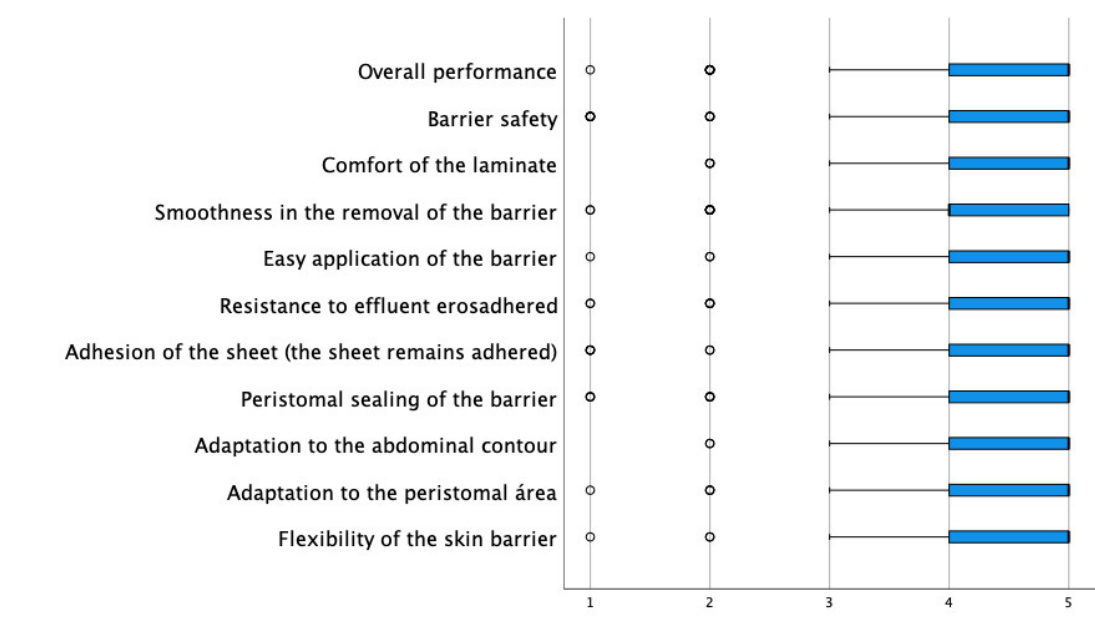
Figure 1. Distribution of scores in the evaluation of the usefulness of the barrier.